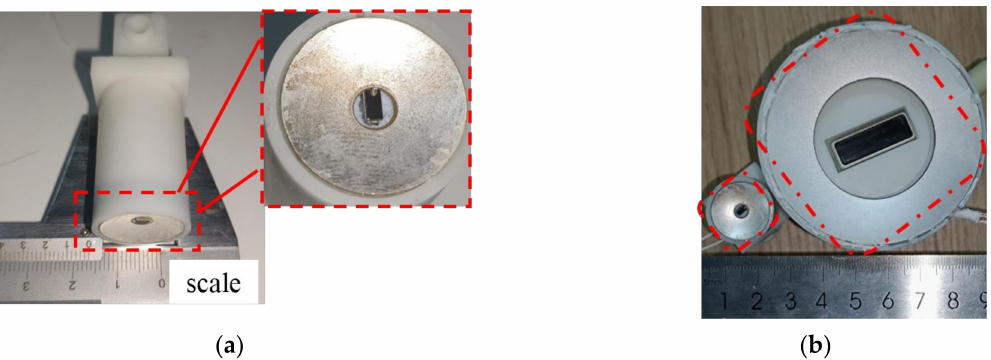
Figure 1. Prototype probe for integrated ultrasound imaging and therapy: ( a ) system guided by a single-element imaging probe; ( b ) dimensional comparison, the right is a system guided by a B-mode imaging probe.